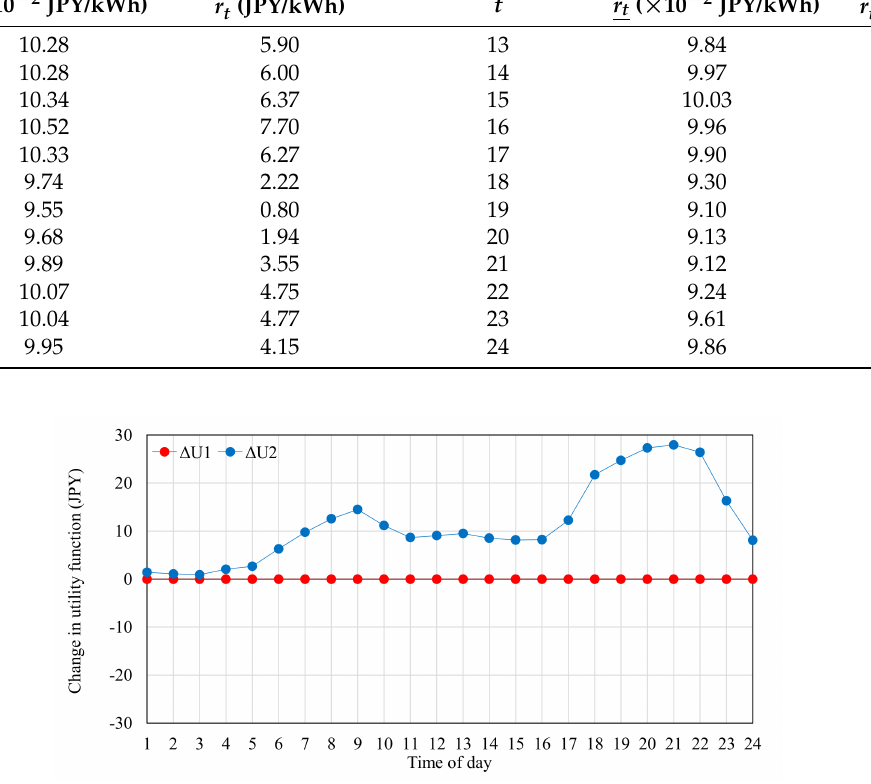
Figure 11. Changes in each function by the 1% DR request in the day of the highest electricity consumption.